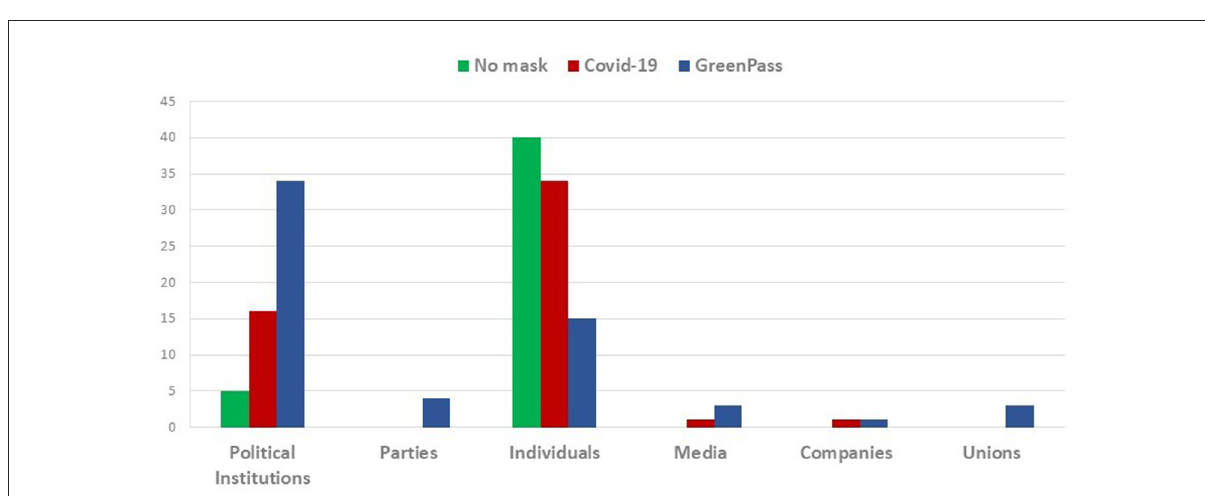
FIGURE1 Top 10 tweets: distribution of hashtag for different sources.